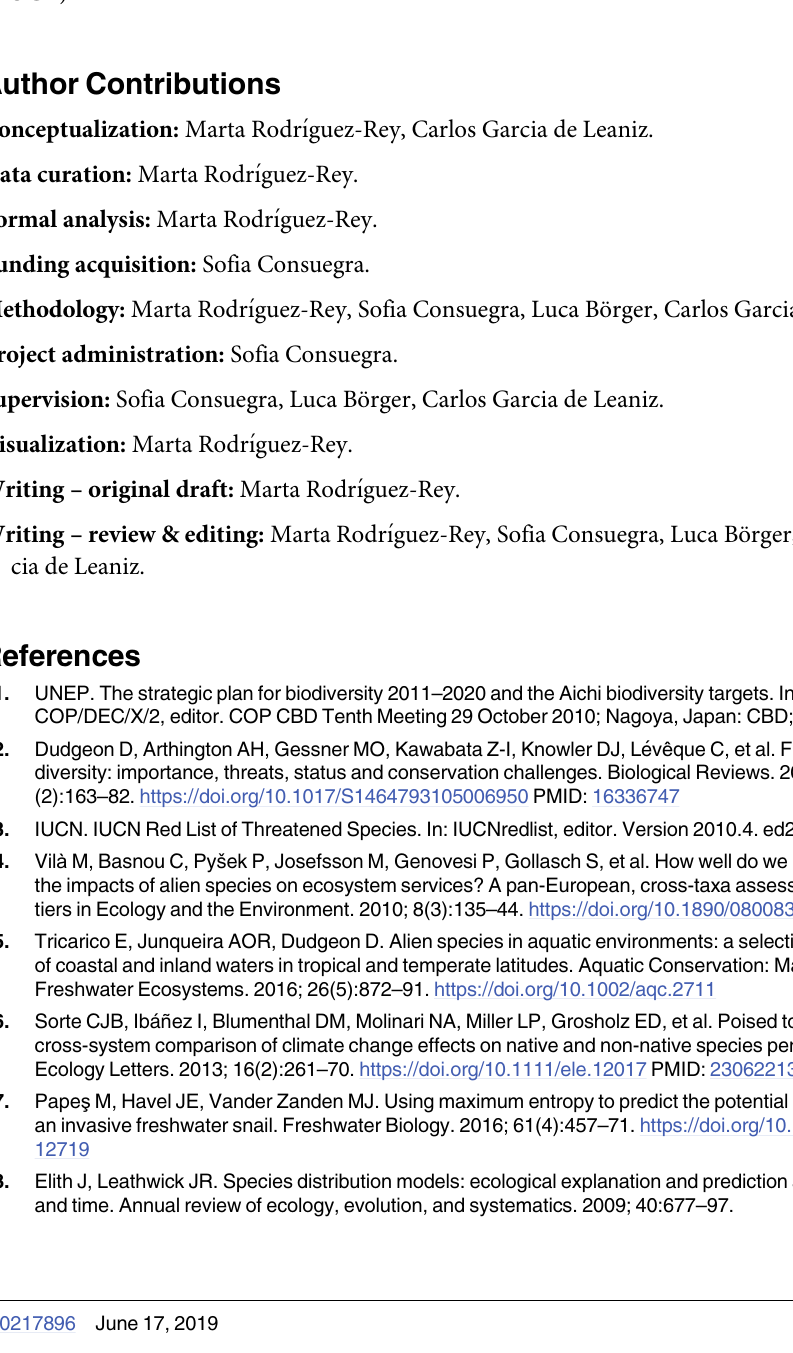
S1 Table. True Skill Statistic (TSS) and Area Under the Curve (AUC) results for real and null models for eleven species, two algorithms and the ensemble, and three scenarios. Effect size corresponds to the difference between the real model and the highest 95CI values of both discrimination